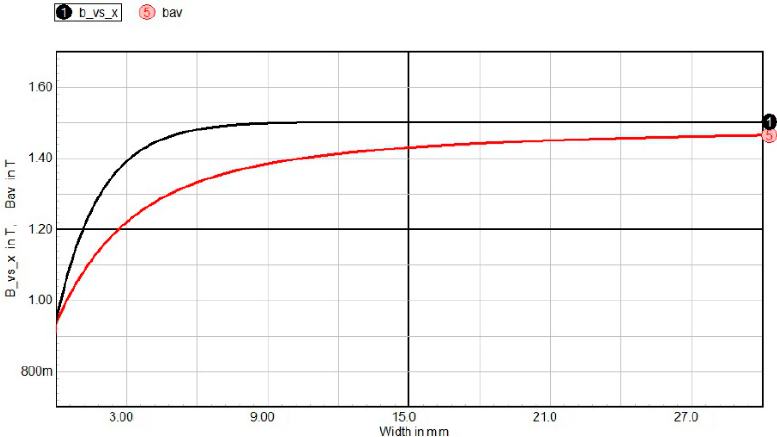
Figure 4. The amplitude profiles of local (black) and average flux density (red) (over an actual strip width), obtained from the analytical model ( H max = 840 A/m). The strips cut at an angle of 0 degrees. An image from the ICAP/4 postprocessor.